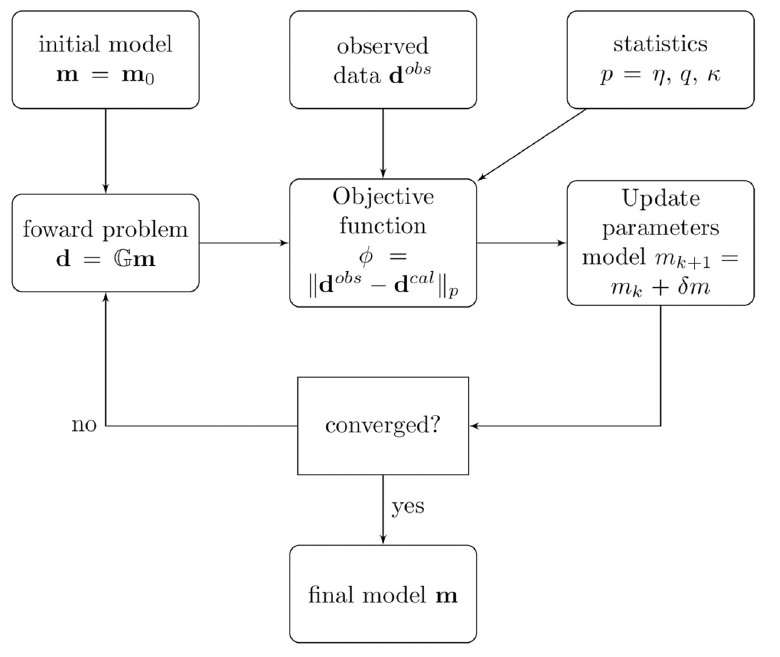
Fig 1. Workflow of the computational